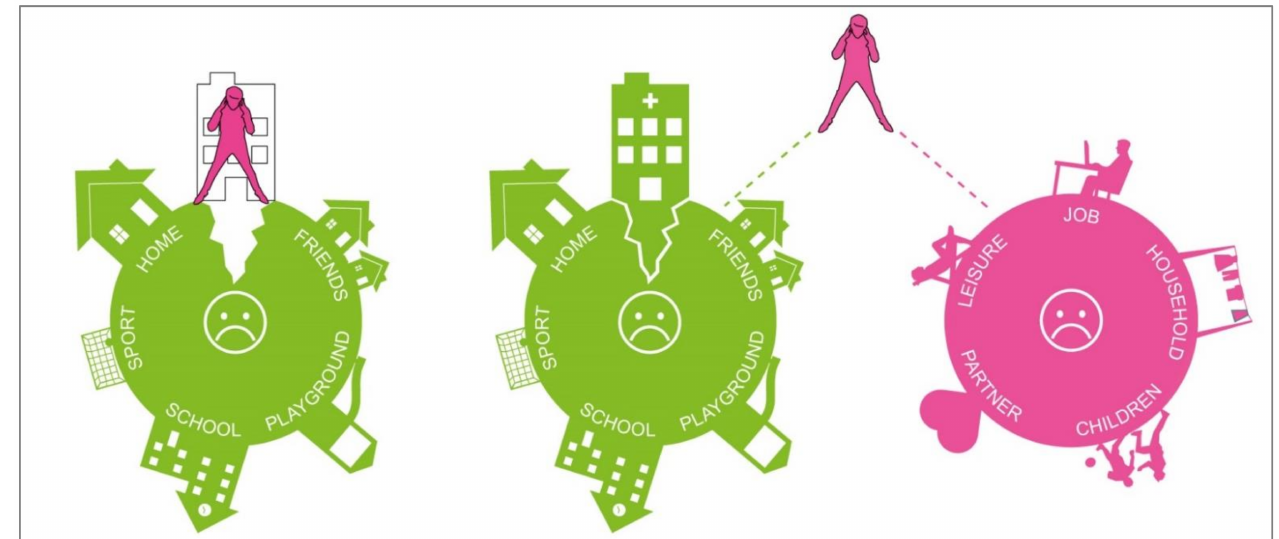
Figure 5. Graphical depiction of the so-called parenting balancing act